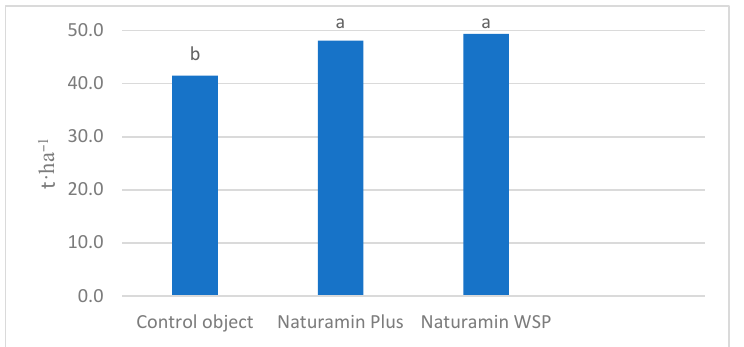
Figure 6. The effect of foliar biological agents based on amino acids on potato tuber yield. a,b-mean values indicated by the same letters are not statistically significant at the 0.05 level by Tukey’s test.